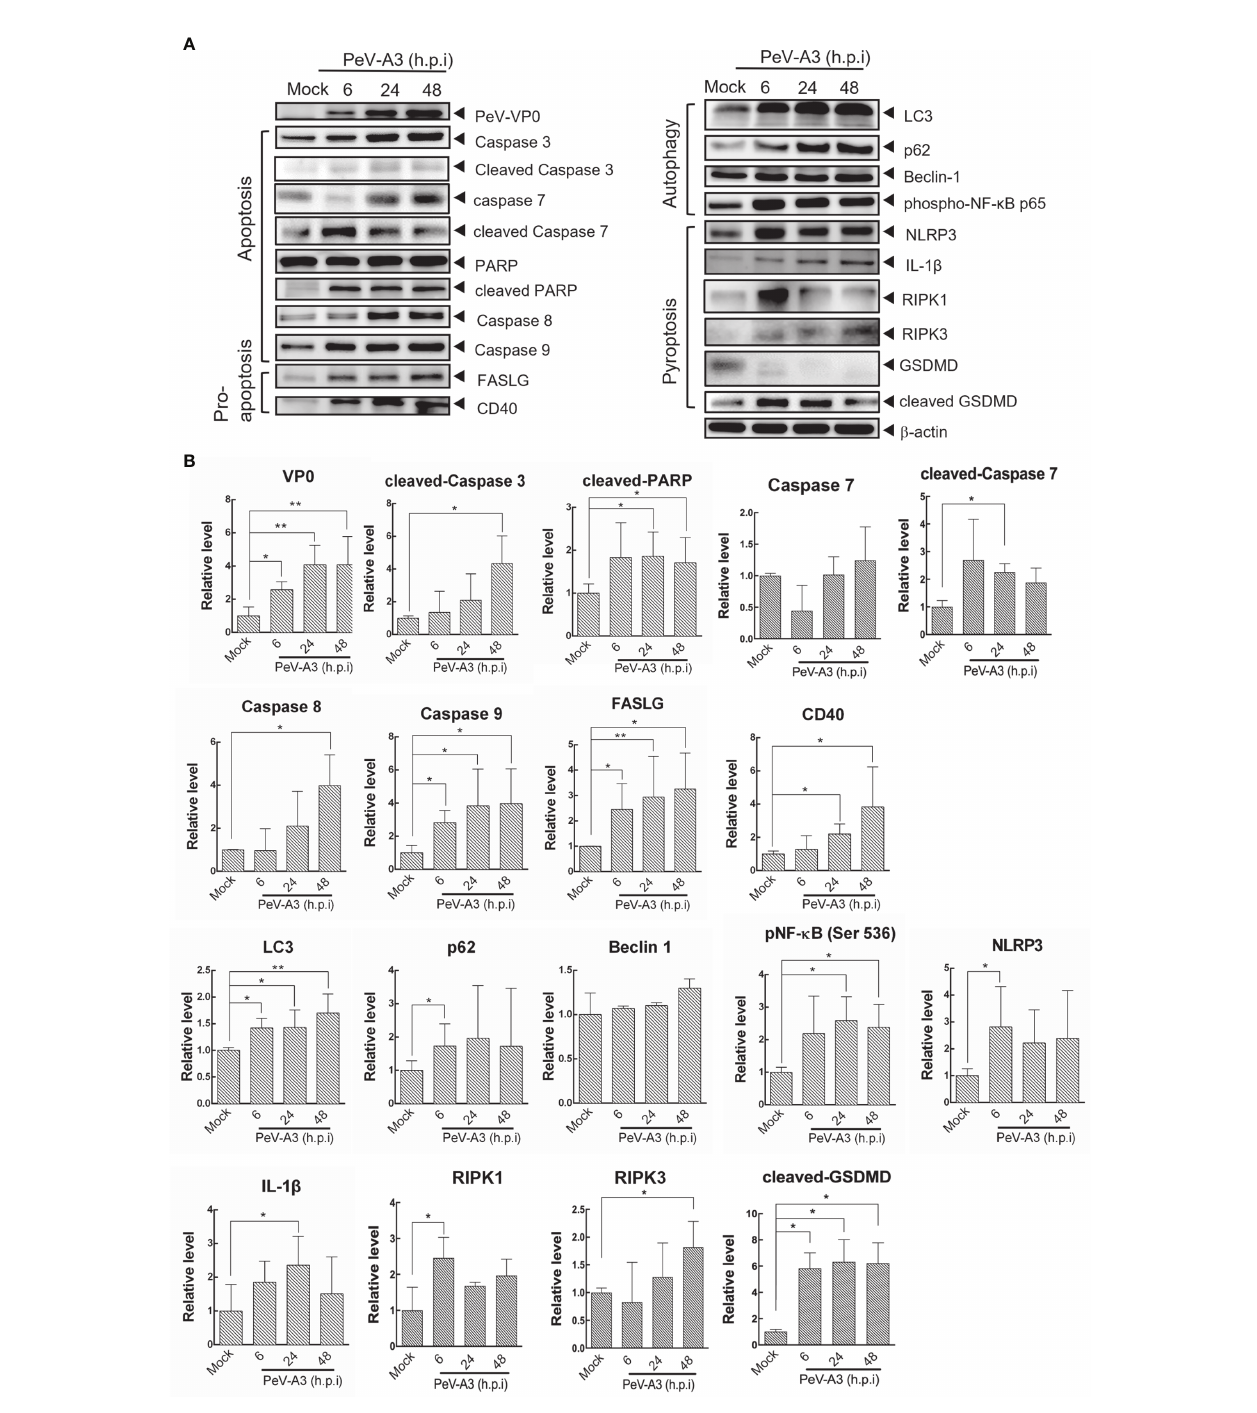
FIGURE 4 | Cell death signaling analysis in PeV-A3-infected GBM cells. (A) GBM cells were infected with PeV-A3 at MOI = 1 for 6, 24, and 48 h. Cell extracts were employed to analyze cell death signaling pathways by Western blotting using anti-PeV VP0, anti-caspase 3, anti-PARP, anti-caspase 8, anti-caspase 9, anti-FASLG, anti-CD40, anti-LC3, anti-p62, anti-beclin 1, anti-phospho-NF- k B p65 (Ser536), anti-NLRP3, anti-IL1 b , anti-RIPK1, anti-RIPK3, anti-GSDMD, and anti- b -actin. (B) Quanti fi ed expression of different proteins was normalized to b -actin. Data are mean ± SD of three independent experiments. Student ’ s t-test, * p < 0.05; ** p < 0.01 compared with mock controls. PeV-A3, parechovirus type 3; GBM, glioblastoma; MOI, multiplicity of